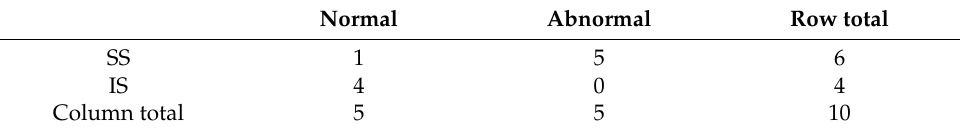
Figure 2. Difference in F-measure between a personalized classifier and a generic classifier for four recognized activity categories. Table 4. Distribution of SS and IS among Normal group and Abnormal group.